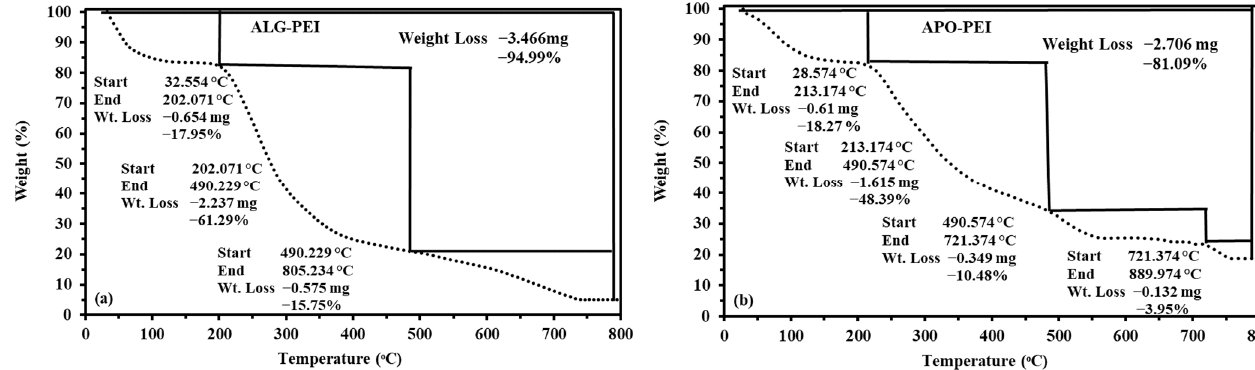
Figure A2. Textural analysis of APO-PEI sorbents: ( a ) N 2 sorption and desorption isotherms (BET method) and ( b ) pore size distribution (BJH method).